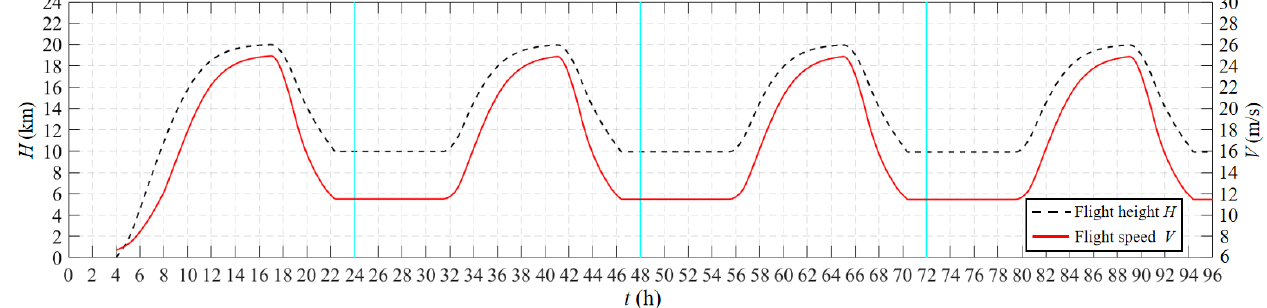
Figure 18. Flight altitude and speed of typical flight profile.